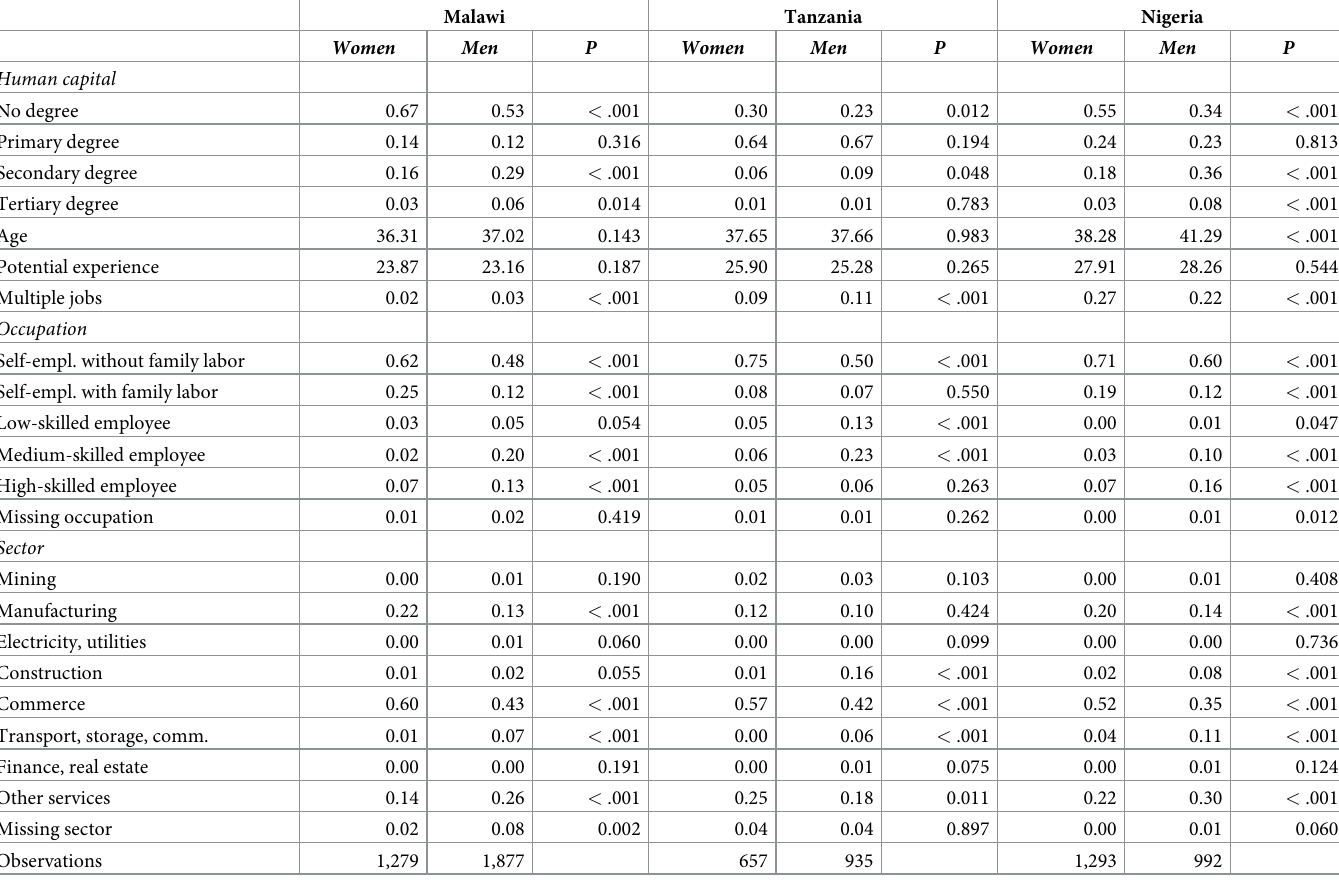
Table 2. Descriptive statistics across gender for non-farm employed people aged 25–55 in rural Malawi, Tanzania and Nigeria. Malawi Tanzania